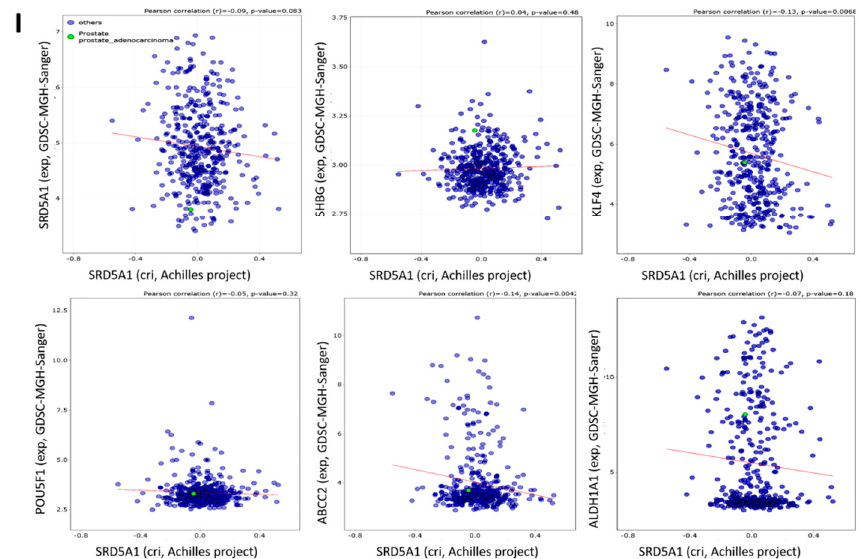
Figure 5. Molecular fine-tuning of components of the 4-gene PCa signature modulate the highly proliferative, metastatic and cancer stem-cell-like (cum disease recurrent) phenotypes of PCa cells. ( A ) Heatmap of the differential expression of SHBG, HSD17B2, TWIST1, SLUG, SNAIL, VIM, TP53, SRD5A1, and GAPDH in the 22Rv1, DU145, LNCaP, MDA-PCa 2b, NCI-H660, PC-3, and VCaP prostate cancer cell lines from the NIH GDC Cancer Cell Line Encyclopedia. ( B ) Line graph show- ing the effect of SHBG_OE on PC-3 cell proliferation over 8 days. ( C ) Photo-images (upper) and histograms (lower) of the effect of SHBG_OE on PC-3 cell viability on day 0 and day 8. ( D ) Photo- images (upper) and histograms (lower) of the effect of SHBG_OE on PC-3 cell migration or invasion. ( E ) Photo-images and histograms showing the differential effects of SHBG_OE or sgSRD5A1 on the formation of primary or secondary tumorspheres by PC-3 or LNCaP cells. ( F ) Representative Western blot images of the differential effects of SHBG_OE or sgSRD5A1 on the expression levels of SHBG, SRD5A1, HSD17B2, HSD17B3, KLF4, OCT3/4, ABCC1, and ABCB1 in PC-3 cells. Original figure see Figure S1. ( G ) Heatmap of the differential expression of SHBG, HSD17B2, SOX2, ABCG2, OCT3/4, ALDH1A1, KLF4, SRD5A1, ABCC2, and GAPDH in the 22Rv1, DU145, LNCaP, MDA-PCa 2b, NCI- H660, PC-3, and VCaP prostate cancer cell lines from the NIH GDC Cancer Cell Line Encyclopedia. ( H ) Heatmap of the differential pharmacological effect of Docetaxel on HSD17B2, HSD17B3, SHBG, or SRD5A1 expression in the NCI-60 Human Tumor Cell Lines. Red box shows PCa cell lines. ( I ) Dot and line plots showing the correlation between SRD5A1 knockout by CRISPR and SRD5A1, SHBG, KLF4, POU5F1/OCT4, ABCC2, or ALDH1A1 expression in the GDSC–MGH–Sanger cohort. GAPDH is loading control. GDSC, the genomics of drug sensitivity in cancer project; MGH, Massachusetts General Hospital; Sanger—the Wellcome Sanger Institute (UK). %, percentage; WT, wild type; OE, overexpression; **, p < 0.01; ***, p <